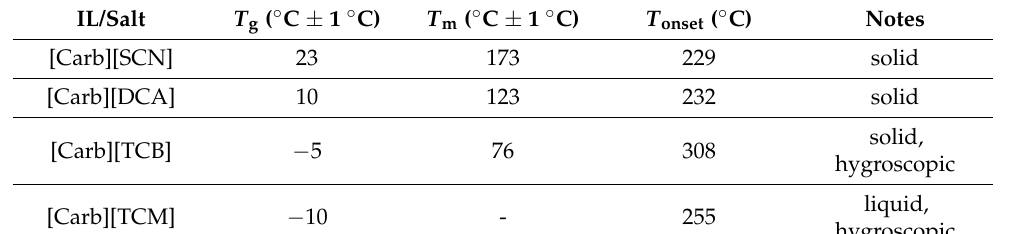
Table 1. Thermal properties of ionic products.